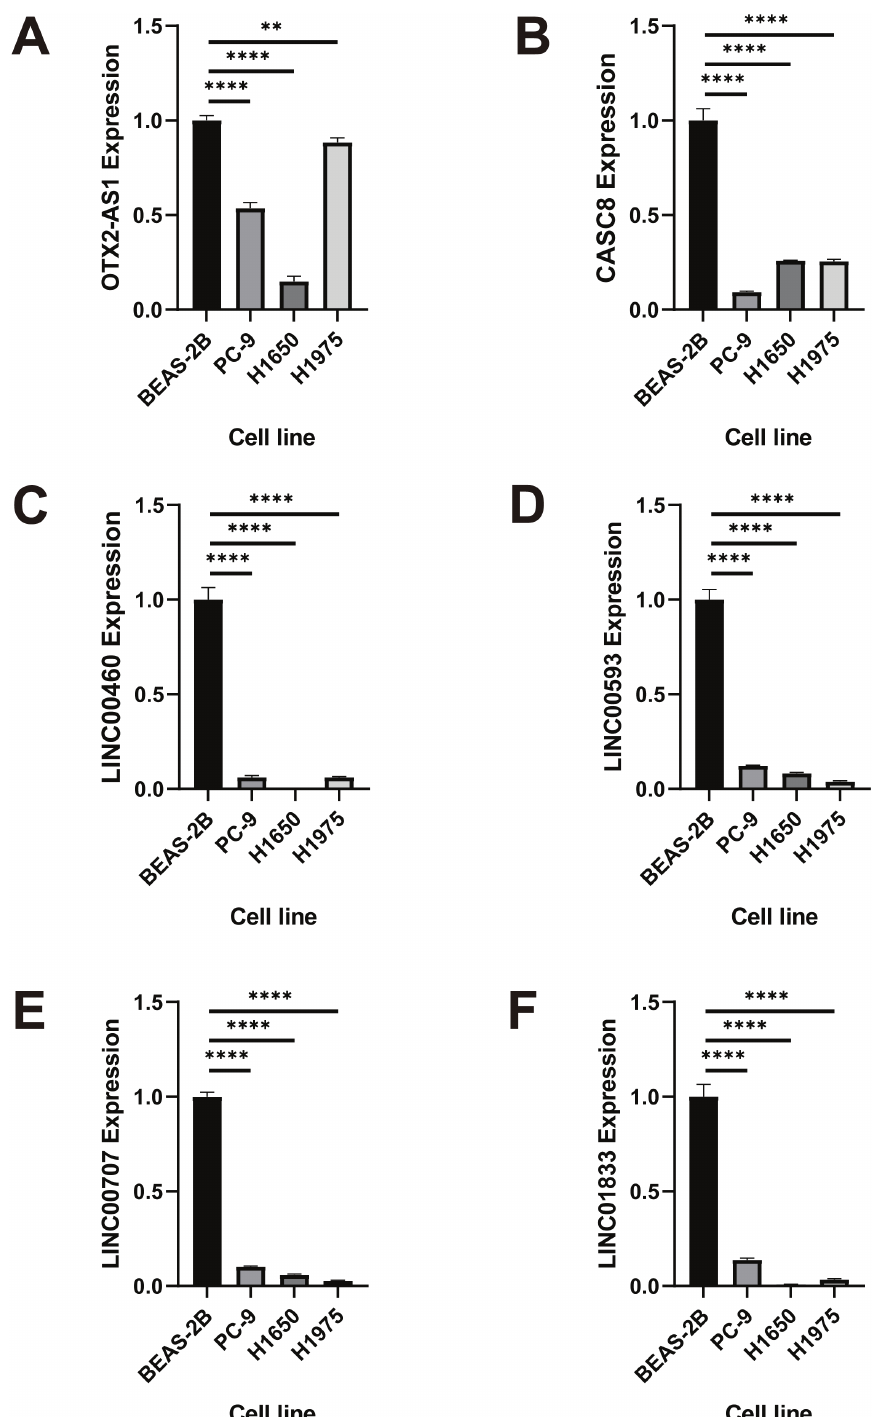
Fig 10. Validation of lncRNAs by RT-qPCR. (A-F) Relative expression levels of LINC00707 , LINC00460 , LINC00593 , LINC01833 , and CASC8 in normal and NSCLC cell lines. Experiments were performed in triplicate, � P < 0.05, �� P < 0.01, ��� P < 0.001, ���� P < 0.0001 by ANOVA. RT-qPCR, quantitative reverse transcription polymerase chain reaction; NSCLC, non-small cell lung cancer.